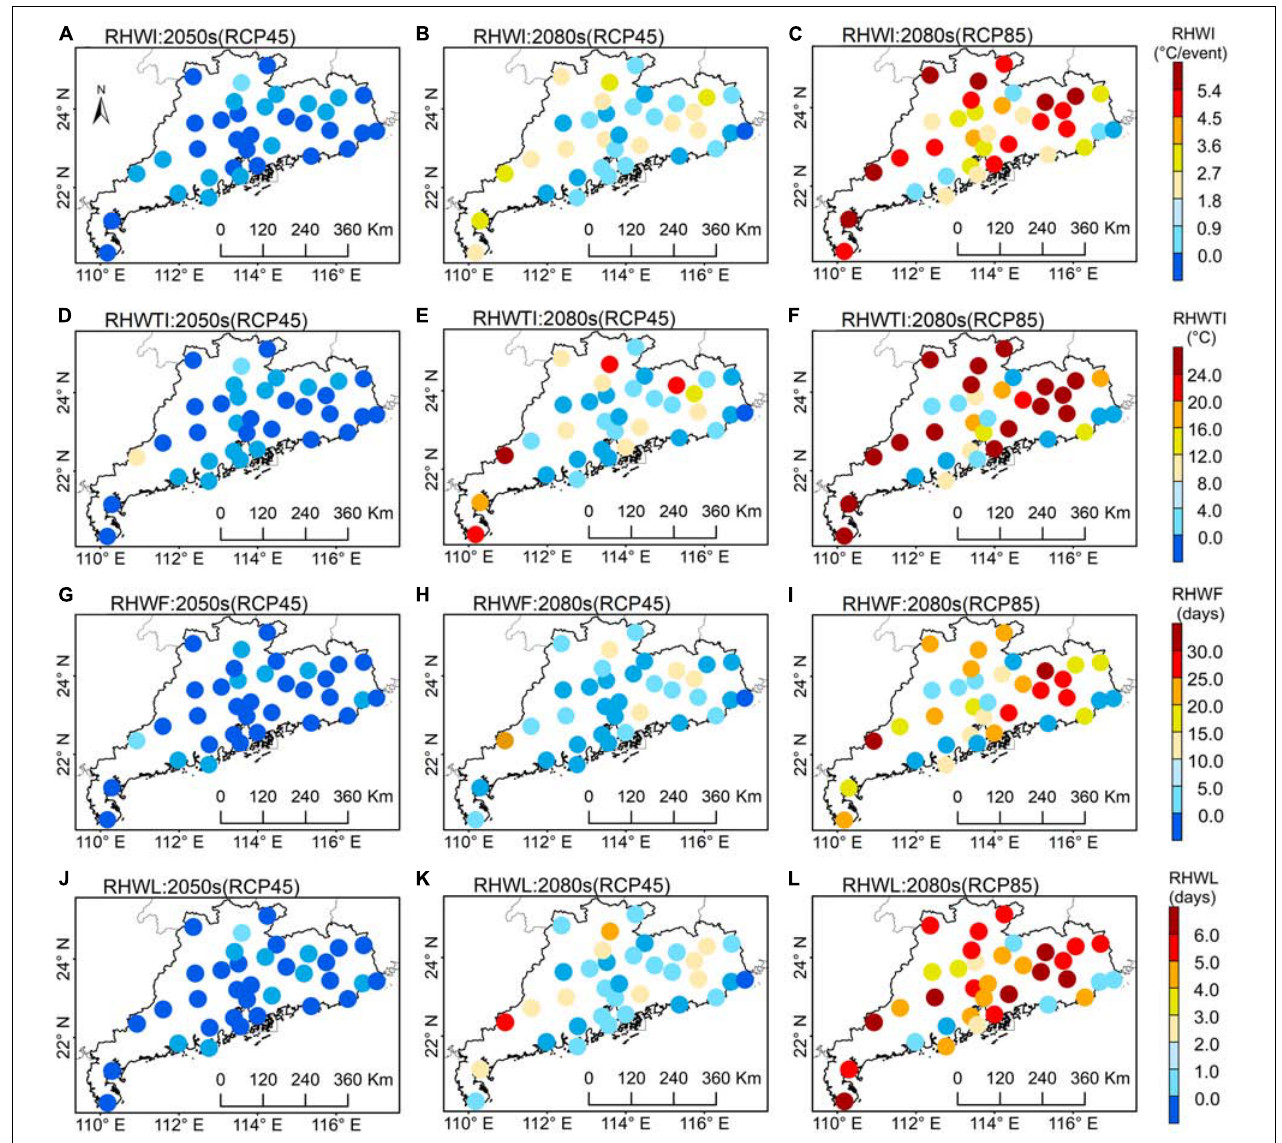
FIGURE 12 | The spatial patterns of the projected changes in relative heat wave indicators [RHWI ( A–C , unit: ◦ C/event), RHWTI ( D–F , unit: ◦ C), RHWF ( G–I , unit: days), and RHWL ( J–L , unit: days)] over Guangdong for the 2050s, 2080s driven by multi-GCMs under RCP4.5 and RCP8.5 scenarios (color dots represent average change